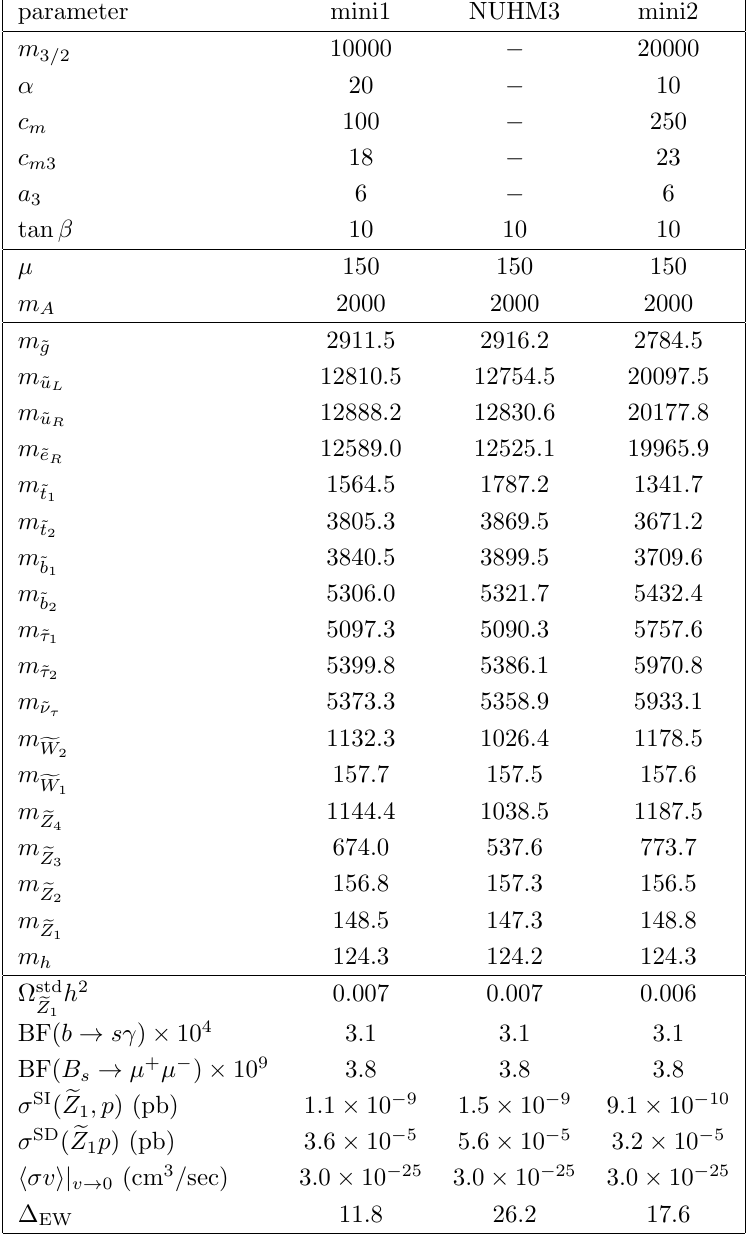
Table 1 . Input parameters and masses in GeV units for a natural mini-landscape SUSY benchmark point as compared to a similar point with gaugino mass uni(cid:12)cation from the NUHM3 model. For the NUHM3 case we take m 0 (1 ; 2) = 12 : 6 TeV, m 0 (3) = 5360 GeV, m Also shown is the spectrum for a second mini-landscape point with m take m t = 173 : 2